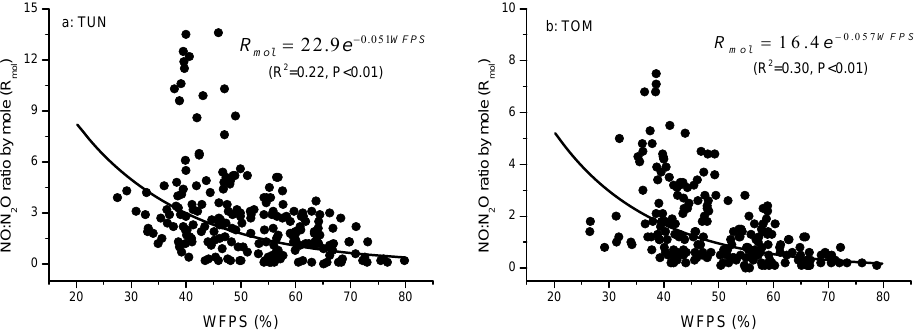
Figure 4. Effect of soil water content (expressed as WFPS, water-filled pore space) on the molar ratios of nitric oxide (NO) to nitrous oxide (N 2 O) fluxes in the fertilized treatments (i.e., the common practice with urea application (TUN), and the alternative practice with organic fertilizer application (TOM)) across the 2-year study